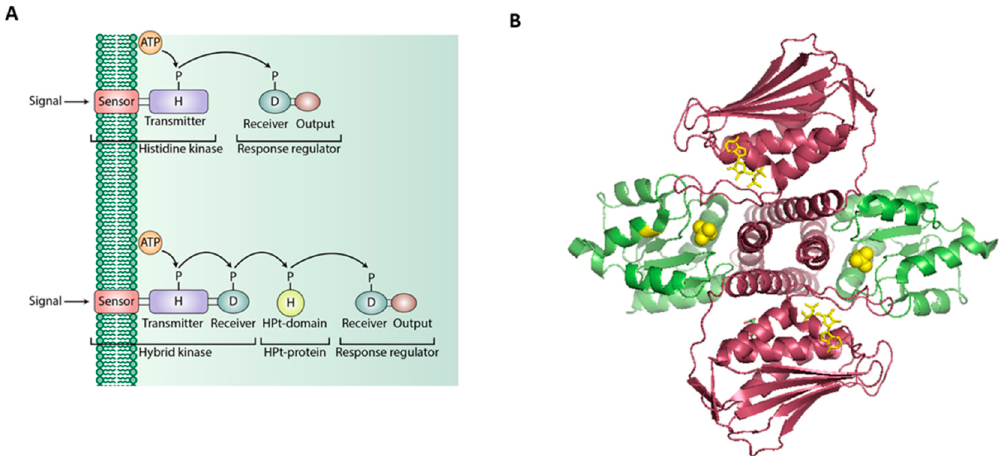
Figure 2. Schematic diagram of the functions and domains of sensor kinase and response regulator proteins in TCSs and HHK-mediated phosphorelays. ( A ) Representation of the classical TCS and phosphorelay signaling systems. ( B ) Structure of the complex between the entire cytoplasmic portion of Thermotoga maritima class I histidine kinase (magenta) and its cognate, response regulator (green) (PDB entry code 3 DGE) [91].